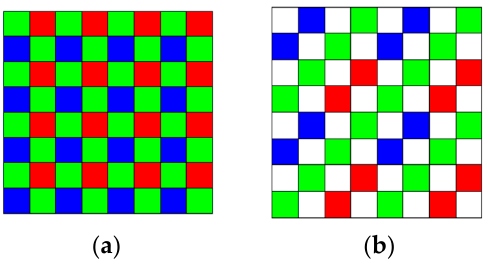
Figure 1. ( a ) Bayer pattern; (b) RGBW (aka color filter arrays (CFA2.0)) pattern.